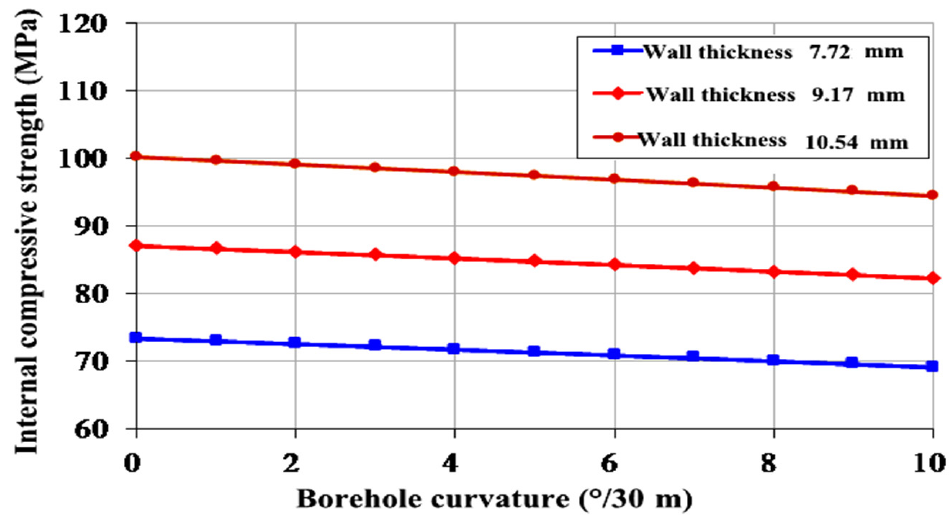
Figure 8. Casing compressive strength under different borehole curvature.